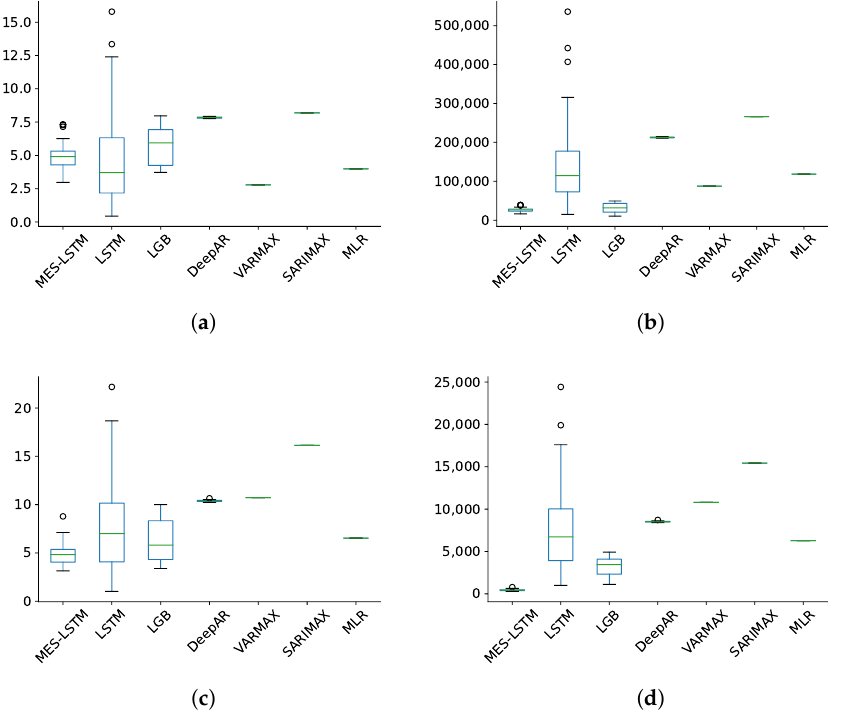
Figure 5. Forecast Accuracy Distribution Boxplots for All Trials in South Africa. ( a ) sMAPE for total cases . ( b ) RMSE for total cases . ( c ) sMAPE for total deaths . ( d ) RMSE for total deaths .